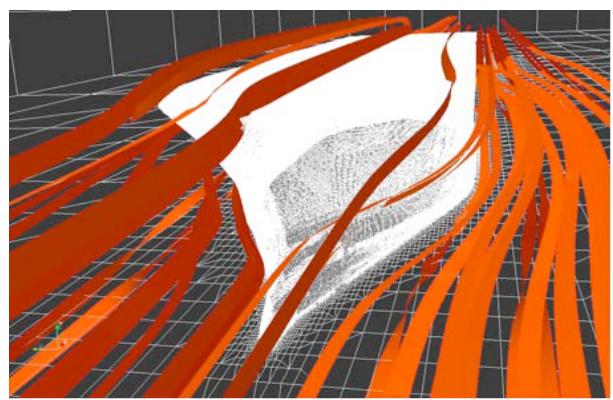
Fig. 1. Streamlines of distorted airflow by the research vessel’s su-